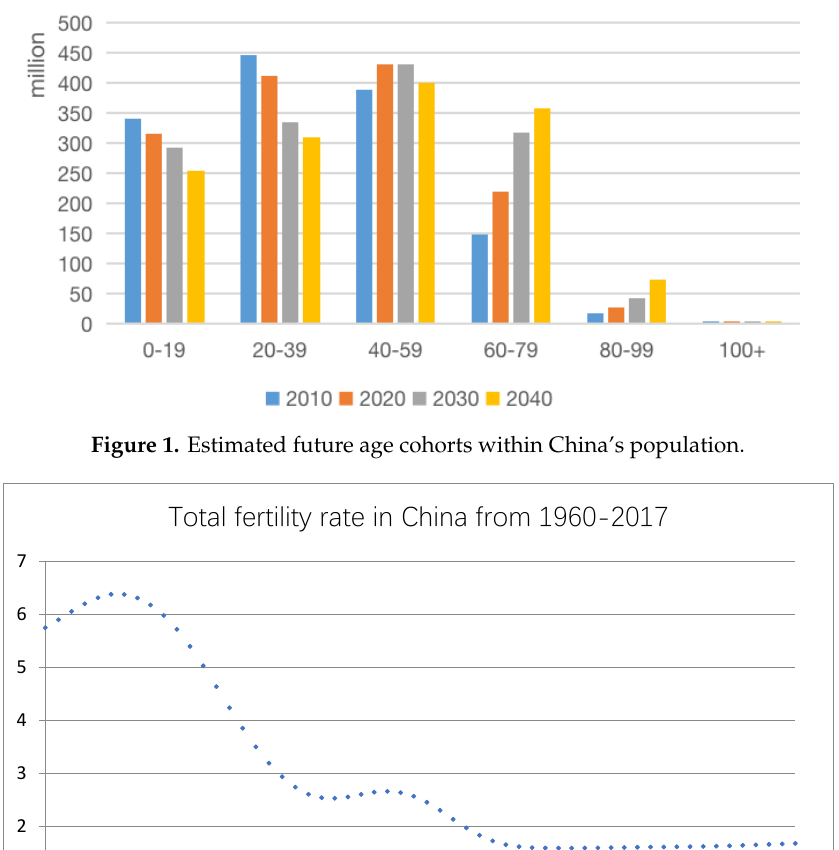
Figure 2. Total fertility rates in China for the period 1960–2017.